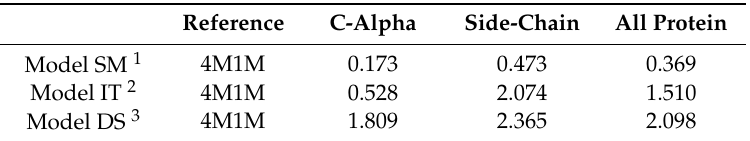
Table 7. RMSD in angstrom of the models selected from each modeling tool with respect to the crystal structure of m P-gp (PDB: 4M1M).